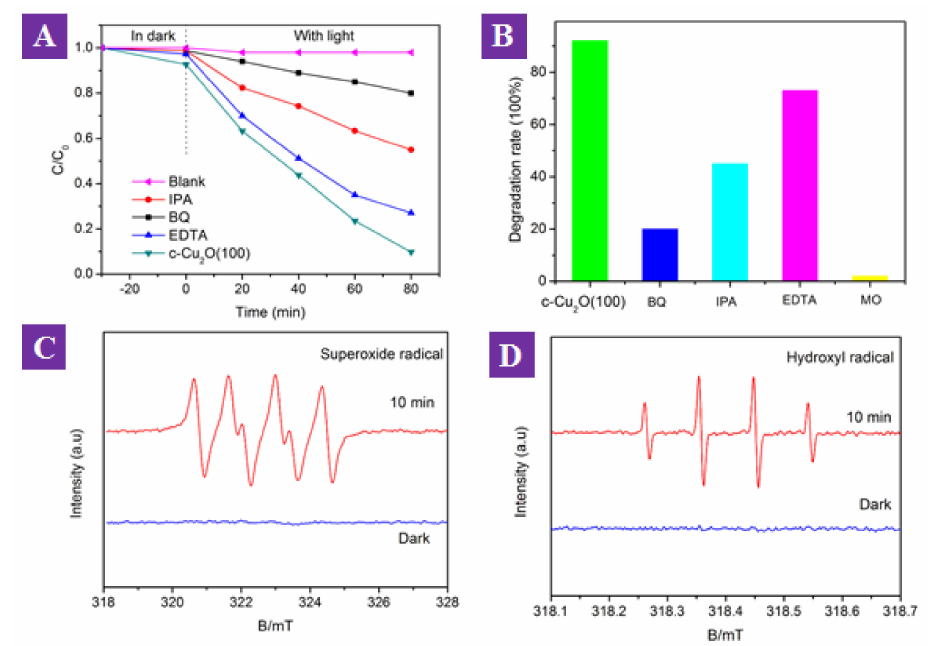
Figure 10. Photocatalytic degradation curve ( A ) and degradation rate ( B ) of MO using c-Cu 2 O nanocrystal photocatalyst with additions of scavengers under visible light, ( C ) ESR-DMPO −· O 2 − and ( D ) ESR-DMPO −· OH spectra of c-Cu 2 O